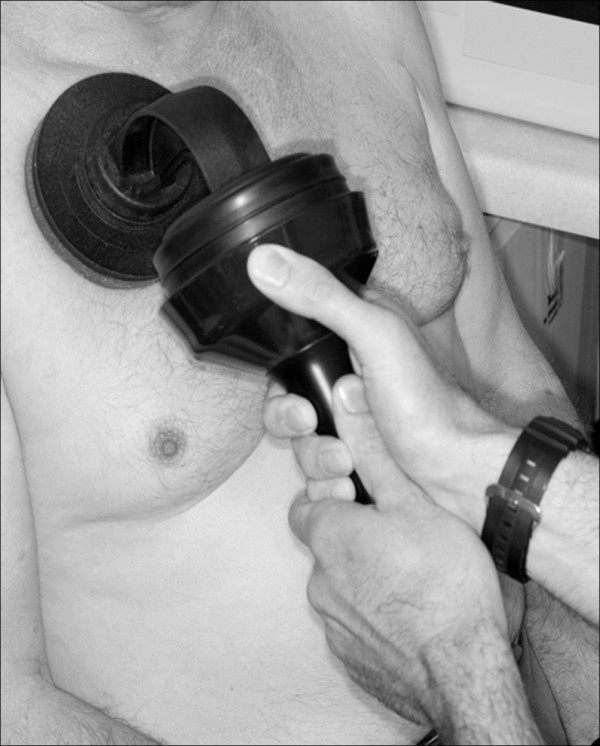
Study subject undergoing mechanical percussion of the chest using a G5 Variko percussor (Physiotherapie Generale, Casteljaloux, France).